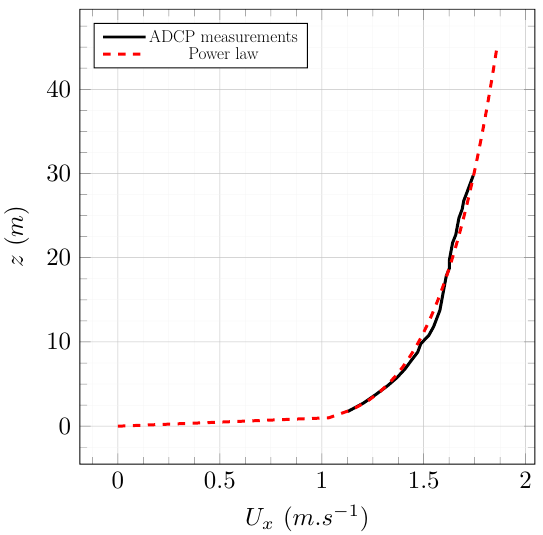
Figure 14. Axial velocity profiles obtained from the power law with n = 6.5 and from ADCP measurements in the Alderney Race during ebb